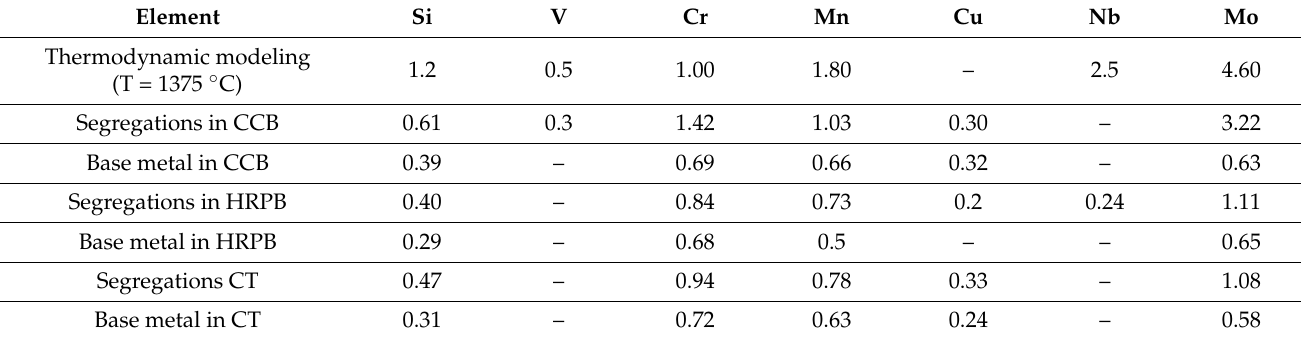
Figure 17. Thermodynamic modeling of impurities content. Table 8. Chemical composition, wt. % (from Tables 3, 4 and 6).